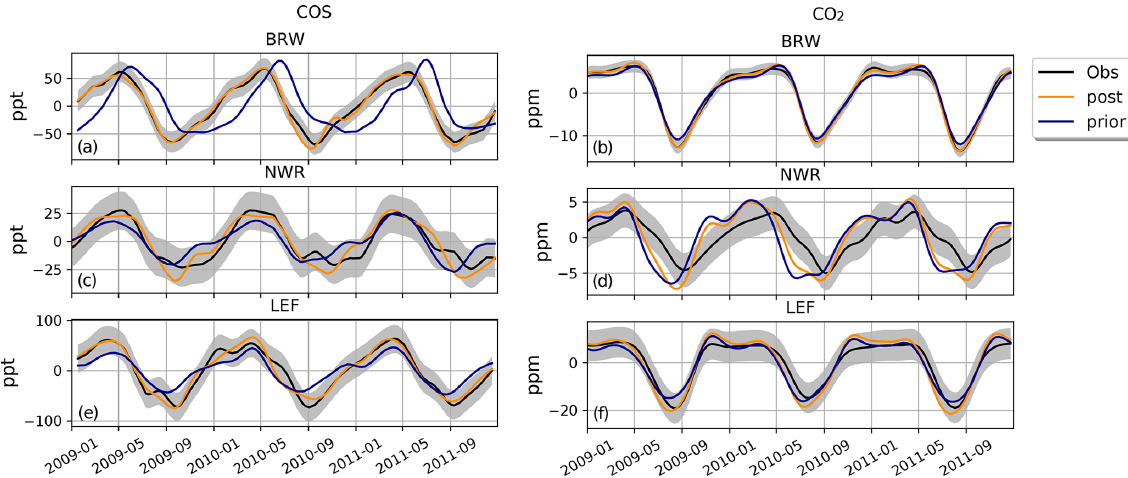
Figure 5. Detrended temporal evolutions of simulated and observed CO 2 and COS concentrations at three selected sites, for the a priori and a posteriori fluxes, simulated between 2009 and 2011. (a, b) Barrow station (BRW, Alaska, USA), (c, d) Niwot Ridge (NWR, USA) and (e, f) Park Falls (LEF, USA). The curves have been detrended beforehand and filtered to remove the synoptic variability (see Sect. 2.6). The grey bar represents the 1 σ error bar of the observations.